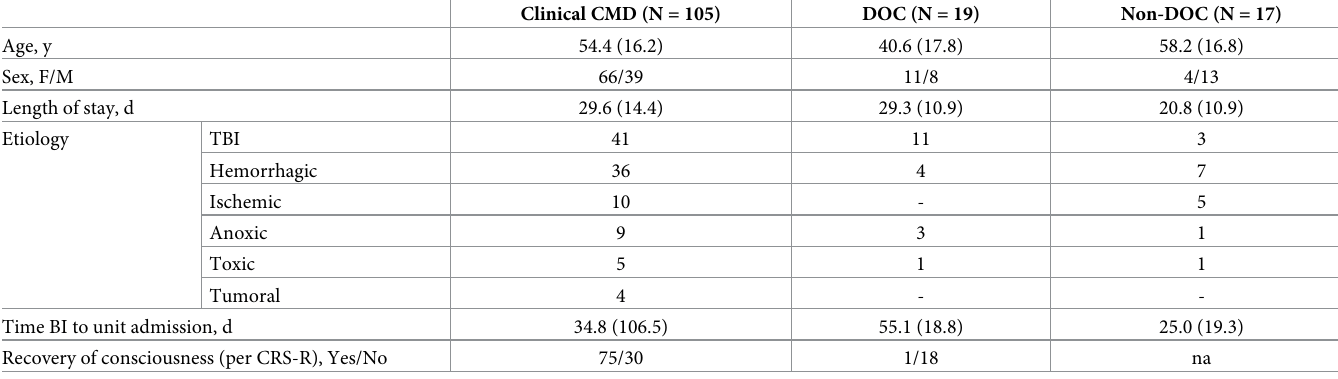
Table 1. Means (and SD) or distribution of demographic, anamnestic and recovery of consciousness per groups designated using the Motor Behavior Tool in com- plement to the Coma Recovery Scale-Revised.